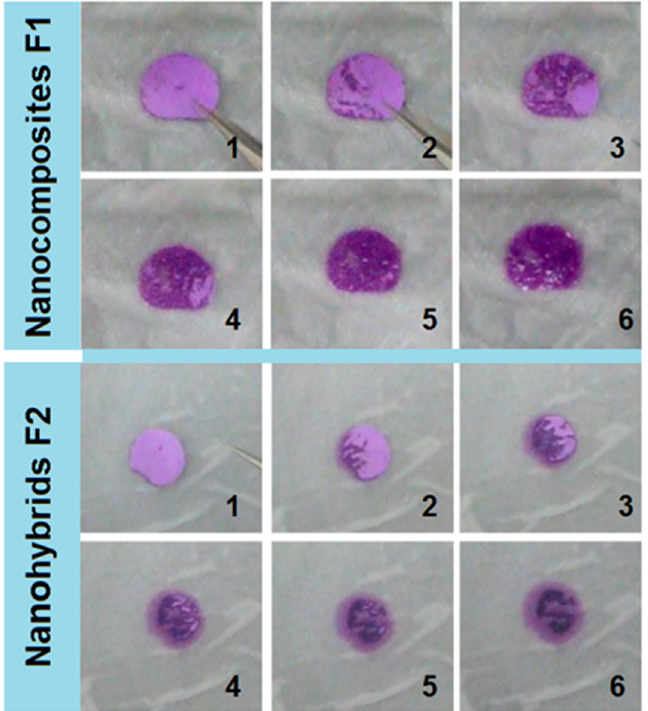
Figure 8. Fast disintegrating experimental results on the wet paper: the electrospun HPMC-based nanocomposites and the electrospun core–shell nanohybrids.